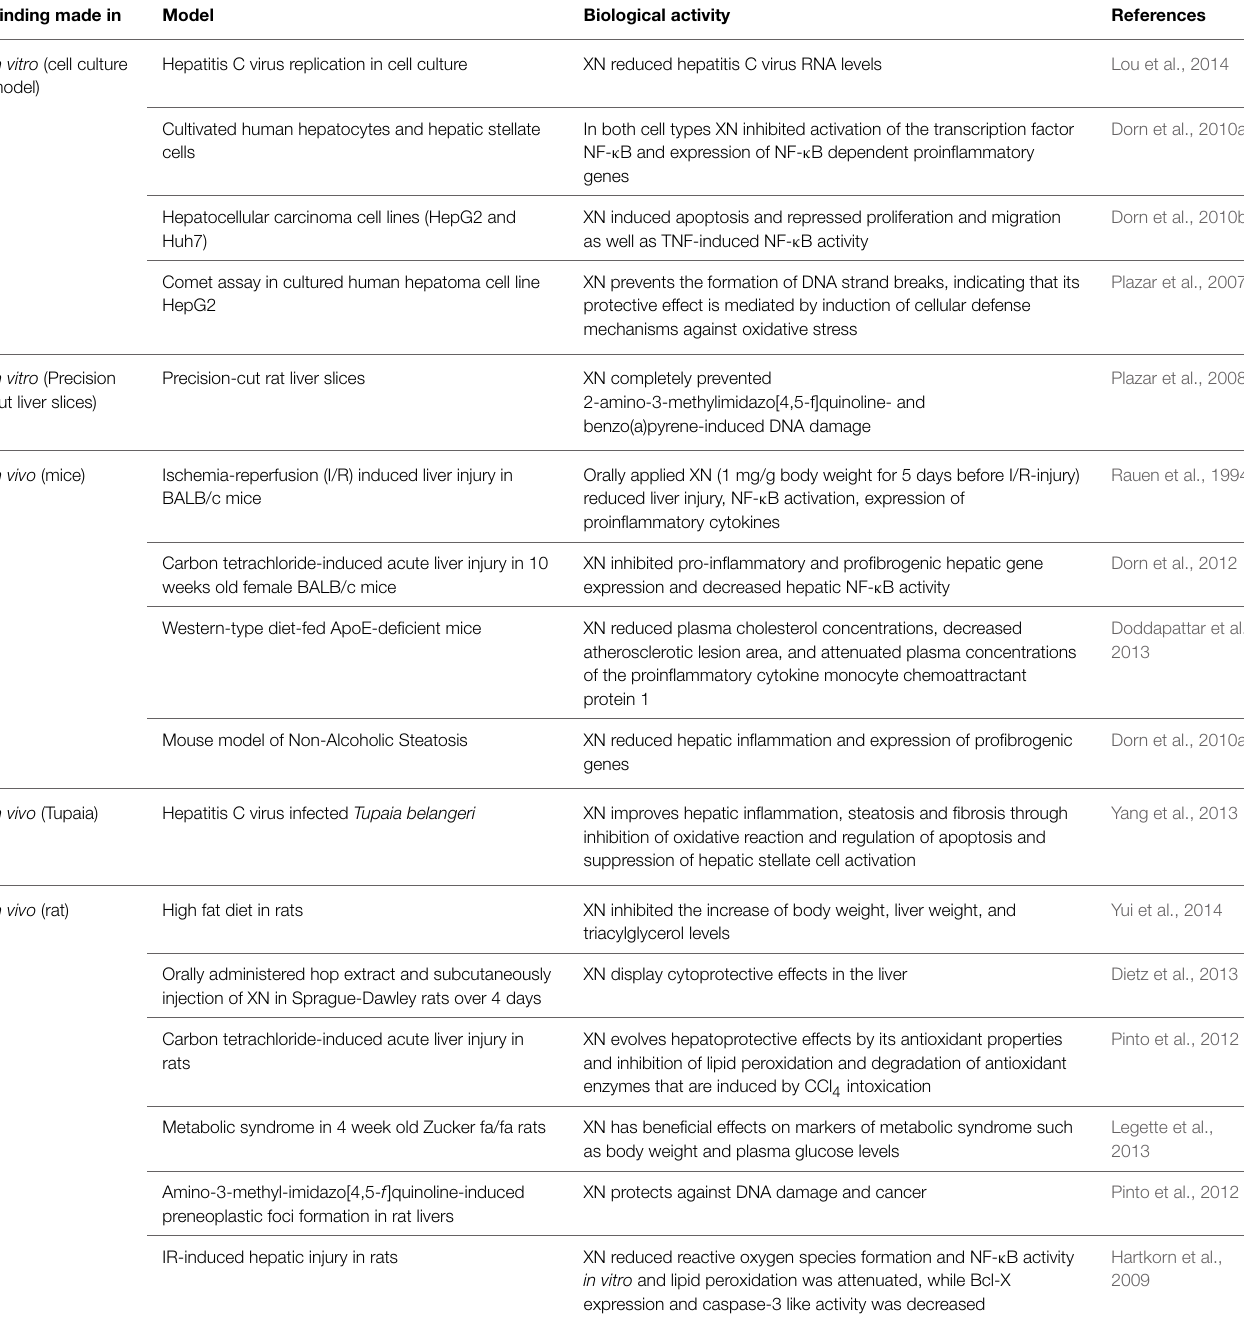
TABLE 1 | Beneficial effects of Xanthohumol on liver